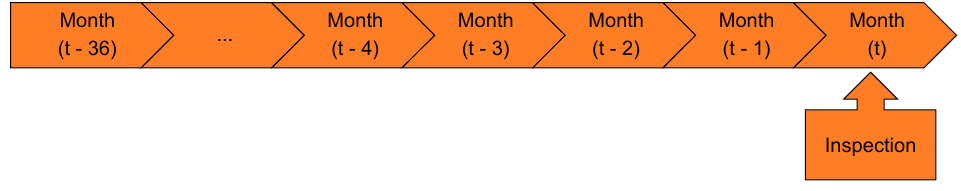
Figure 2. Mining temporal series: Consumption and Temperature.